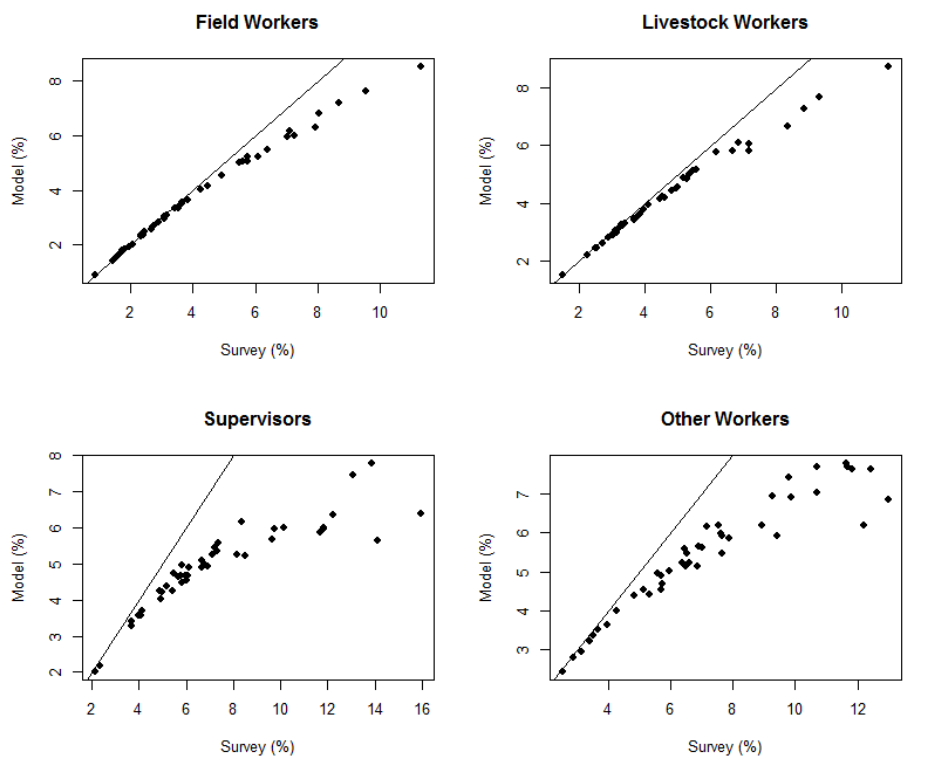
Figure 11. Coefficients of variation (%) for state-level model and survey estimates of average wage rates by worker